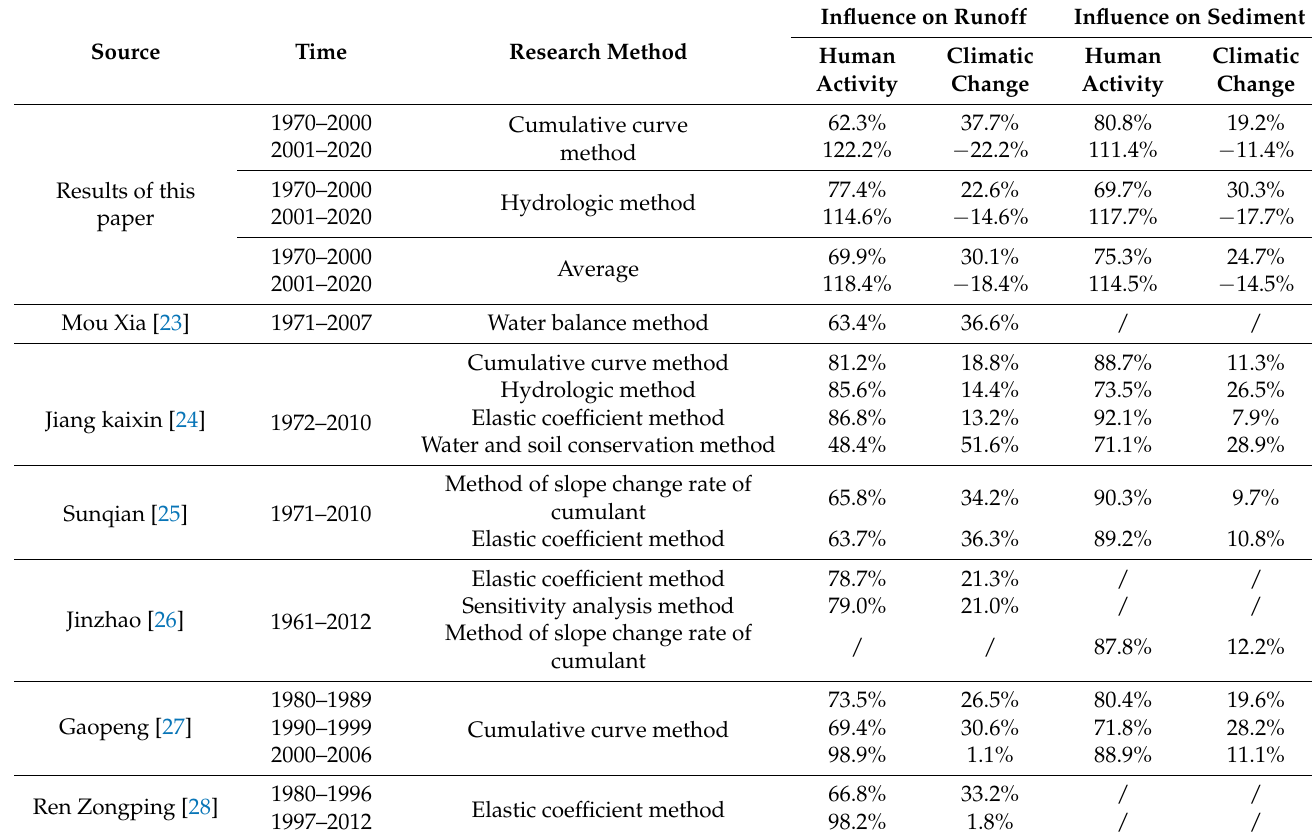
Table 6. Causes of runoff and sediment variation in the Wuding River